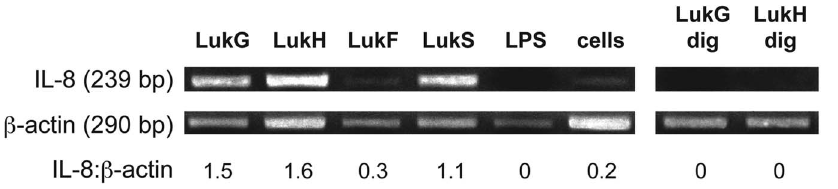
Figure 8. Induction of IL-8 mRNA by individual components of LukGH or PVL. PMNs were incubated for 1 hr alone (cells) or with 500 nM LukG, LukH, LukF-PV, LukS-PV, protease-digested LukG (LukG dig) or LukH (LukH dig), or 50 m g/mL LPS, and total mRNA was isolated from cell lysate. cDNA was synthesized and the DNA was amplified using IL-8 and b -actin specific primers and PCR. The ratio of IL-8 transcripts to b -actin transcripts is shown below the gel image.